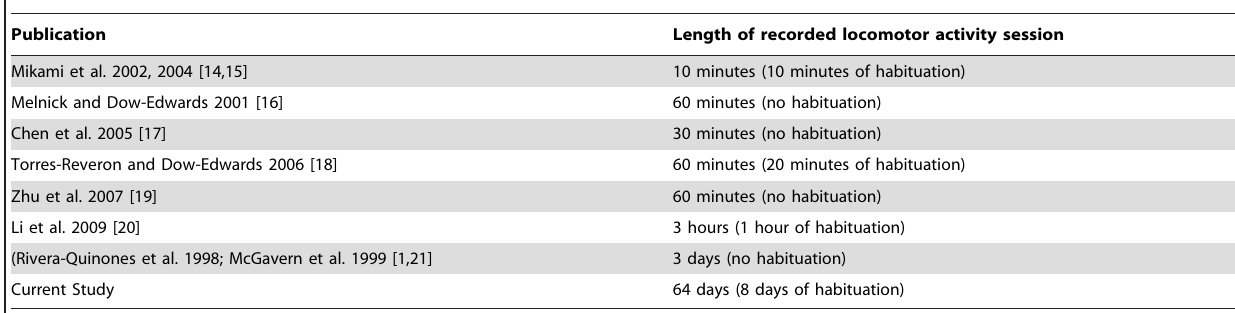
Table 1. Length of the spontaneous activity monitoring in published studies compared to current